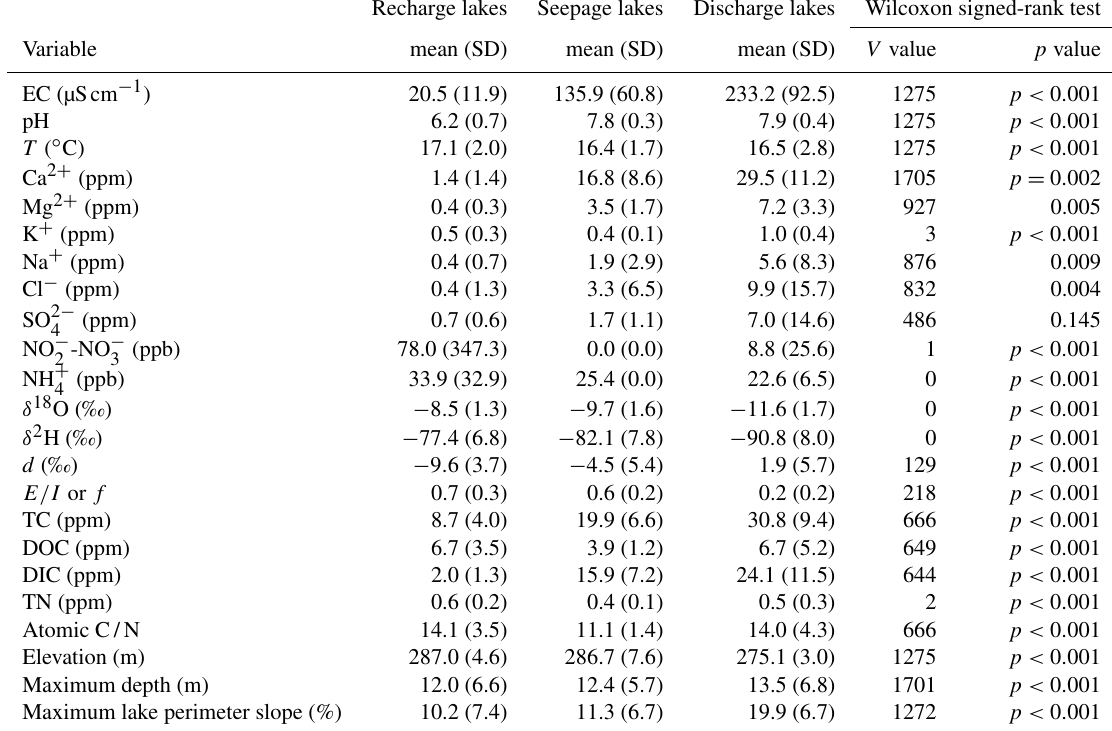
Table A3. Results of the Wilcoxon signed-rank test of conservative and non-conservative hydrological tracers using the three-class lake typology as the categorical variable. Non-significant p values are indicated in bold. Lakes in the recharge zone are defined as lakes above an elevation of 282ma.s.l. that are non-alkaline, and lakes in the seepage zone are defined as lakes above an elevation of 282ma.s.l. that are alkaline, whereas lakes in the discharge zone are defined as lakes located at an elevation of less than 282ma.s.l. Recharge lakes Seepage lakes Discharge